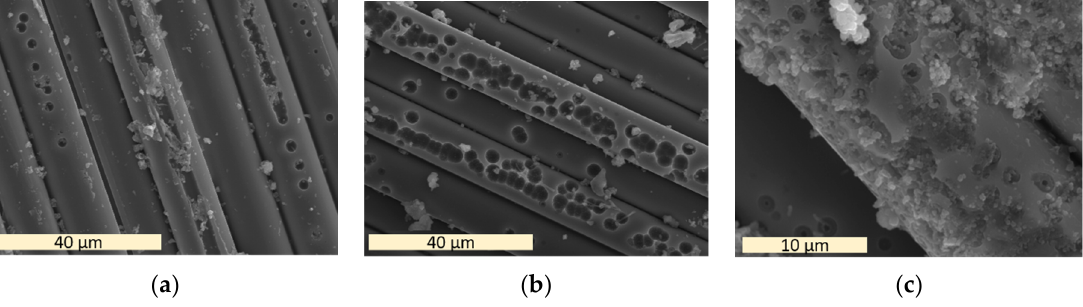
Figure 5. AR fibers immersed in the saturated Ca(OH) 2 solution: ( a ) 28 d at 55 °C; ( b ) for 56 d at 55 °C; and ( c ) for 70 d at 5 °C.